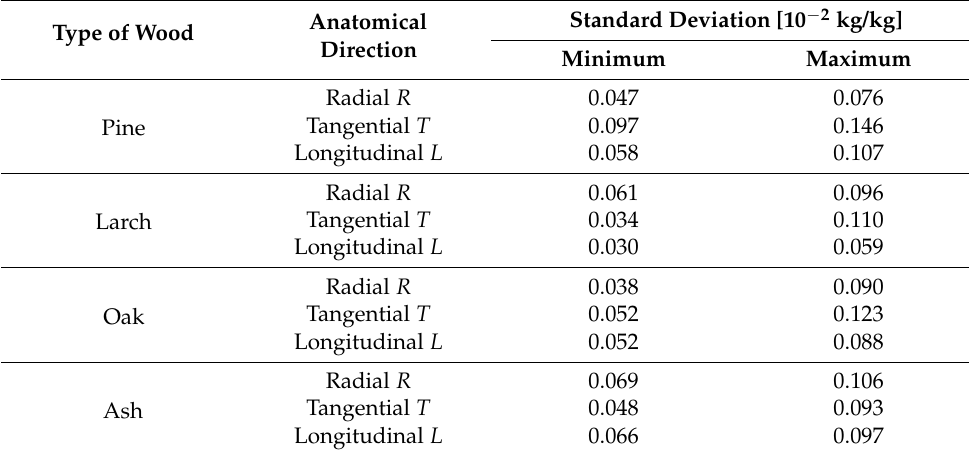
Figure 11. Changes in the moisture content of the ash samples versus time. Table 8. Maximum and minimum values of standard